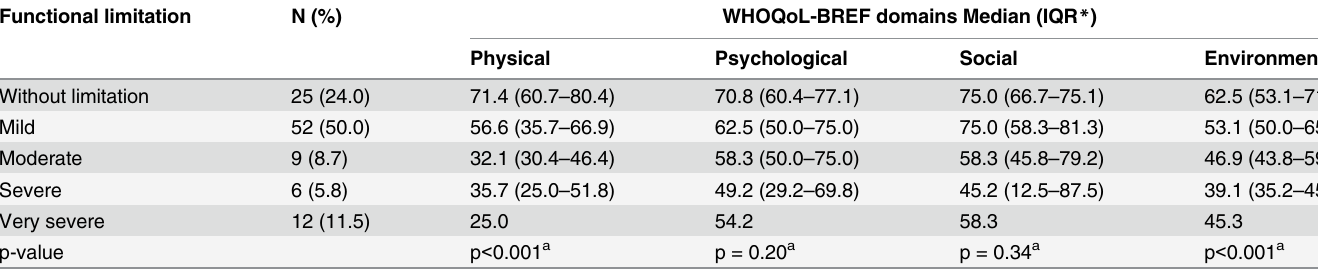
Table 2. WHOQoL-BREF domain scores stratified by functional limitations.